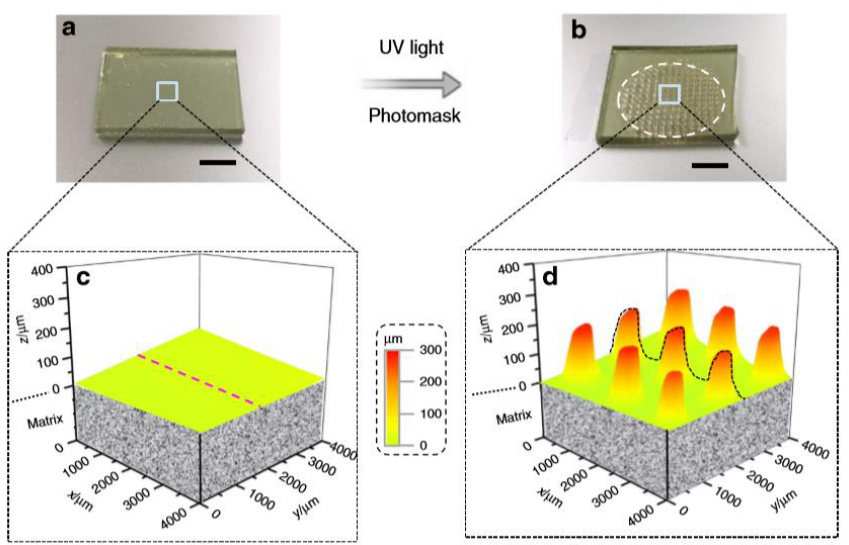
Figure 7. Microstructure pattern grown, ( a ) before UV irradiation, ( b ) after UV irradiation, ( c ) 3D profiles before UV irradiation, ( d ) swollen profile after UV irradiation (Reprinted from reference [92]).